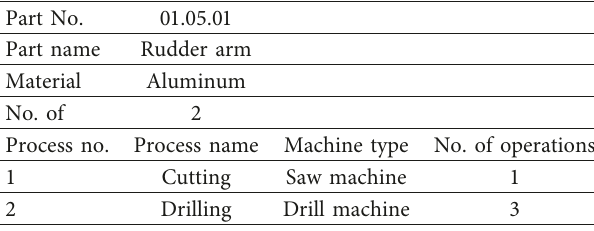
Table 9: Rudder arm.